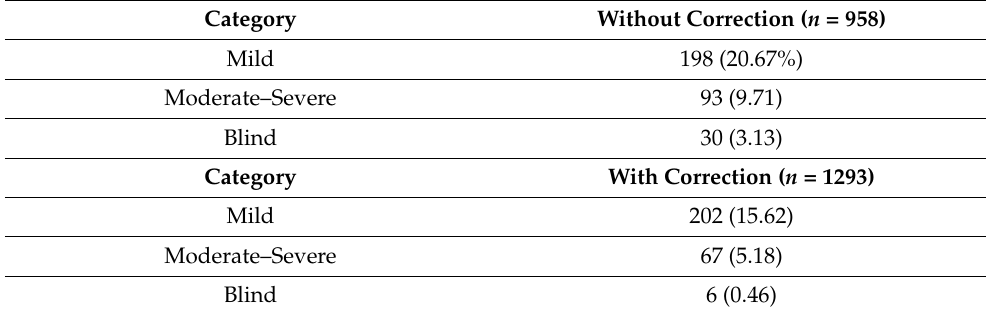
Table 2. Visual impairment,